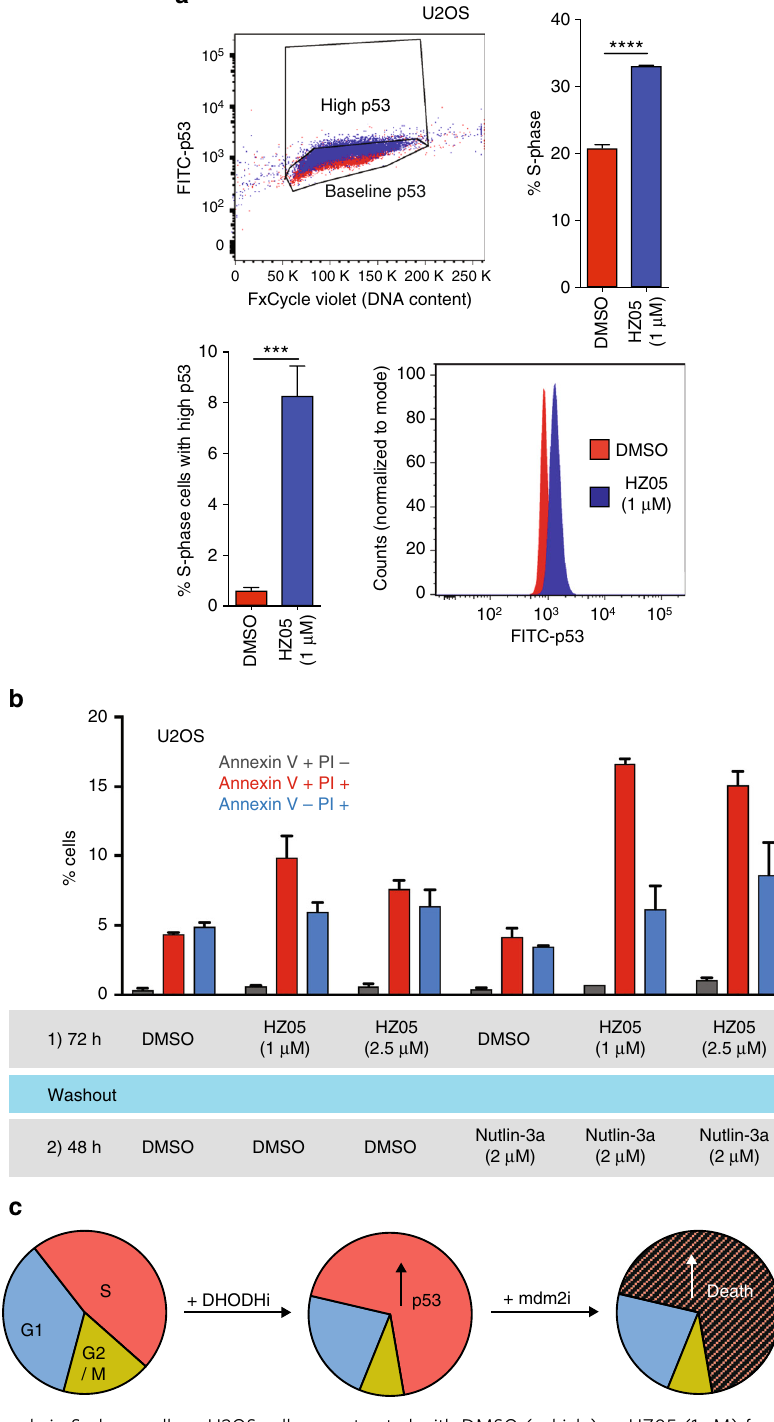
Fig. 7 HZ05 increases p53 levels in S-phase cells. a U2OS cells were treated with DMSO (vehicle) or HZ05 (1 μ M) for 72 h. The upper left panel is a representative dot plot showing the gating strategy for cells expressing high p53 levels (blue: HZ05 treated and red: DMSO treated). The upper right panel shows the percentage of cells in S-phase. The lower left panel shows the percentage of S-phase cells with p53 levels above baseline according to the gating shown in the dot plot. A representative histogram of the fl uorescence intensity of FITC-p53 in S-phase cells is shown in the lower right panel. Bar graphs show the average of three independent experiments. Unpaired t -test was employed to assess statistical signi fi cance using GraphPad Prism version 7 (**** p < 0.0001 and *** p < 0.001). b U2OS cells were pretreated with HZ05 for 72 h, washed with medium containing DMSO or nutlin-3a, and then provided with fresh medium containing DMSO or nutlin-3a. After an additional 48 h, Annexin V and PI staining was analyzed by fl ow cytometry. The average of two independent experiments ± SD is shown. c Hypothetical model describing the combination of DHODH inhibition with mdm2 antagonists. Inhibition of DHODH in tumor cells leads to an increase in the number of cells in S-phase that also possess elevated levels of p53. Inhibition of p53 degradation in the form of an mdm2 antagonist leads to death of cells in